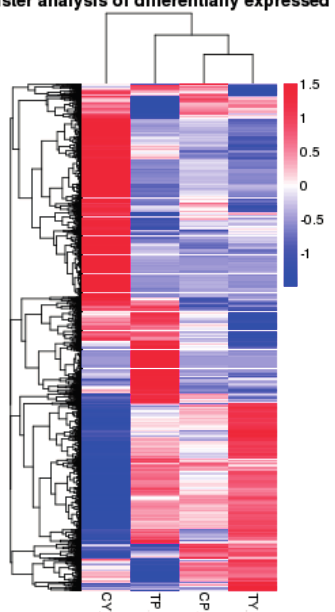
Figure 2. Hierarchical cluster analysis of gene expression based on the log ratio fold change data. The color scale indicates the gene expression level: red color represents increased transcript abundance and blue color represents decreased transcript